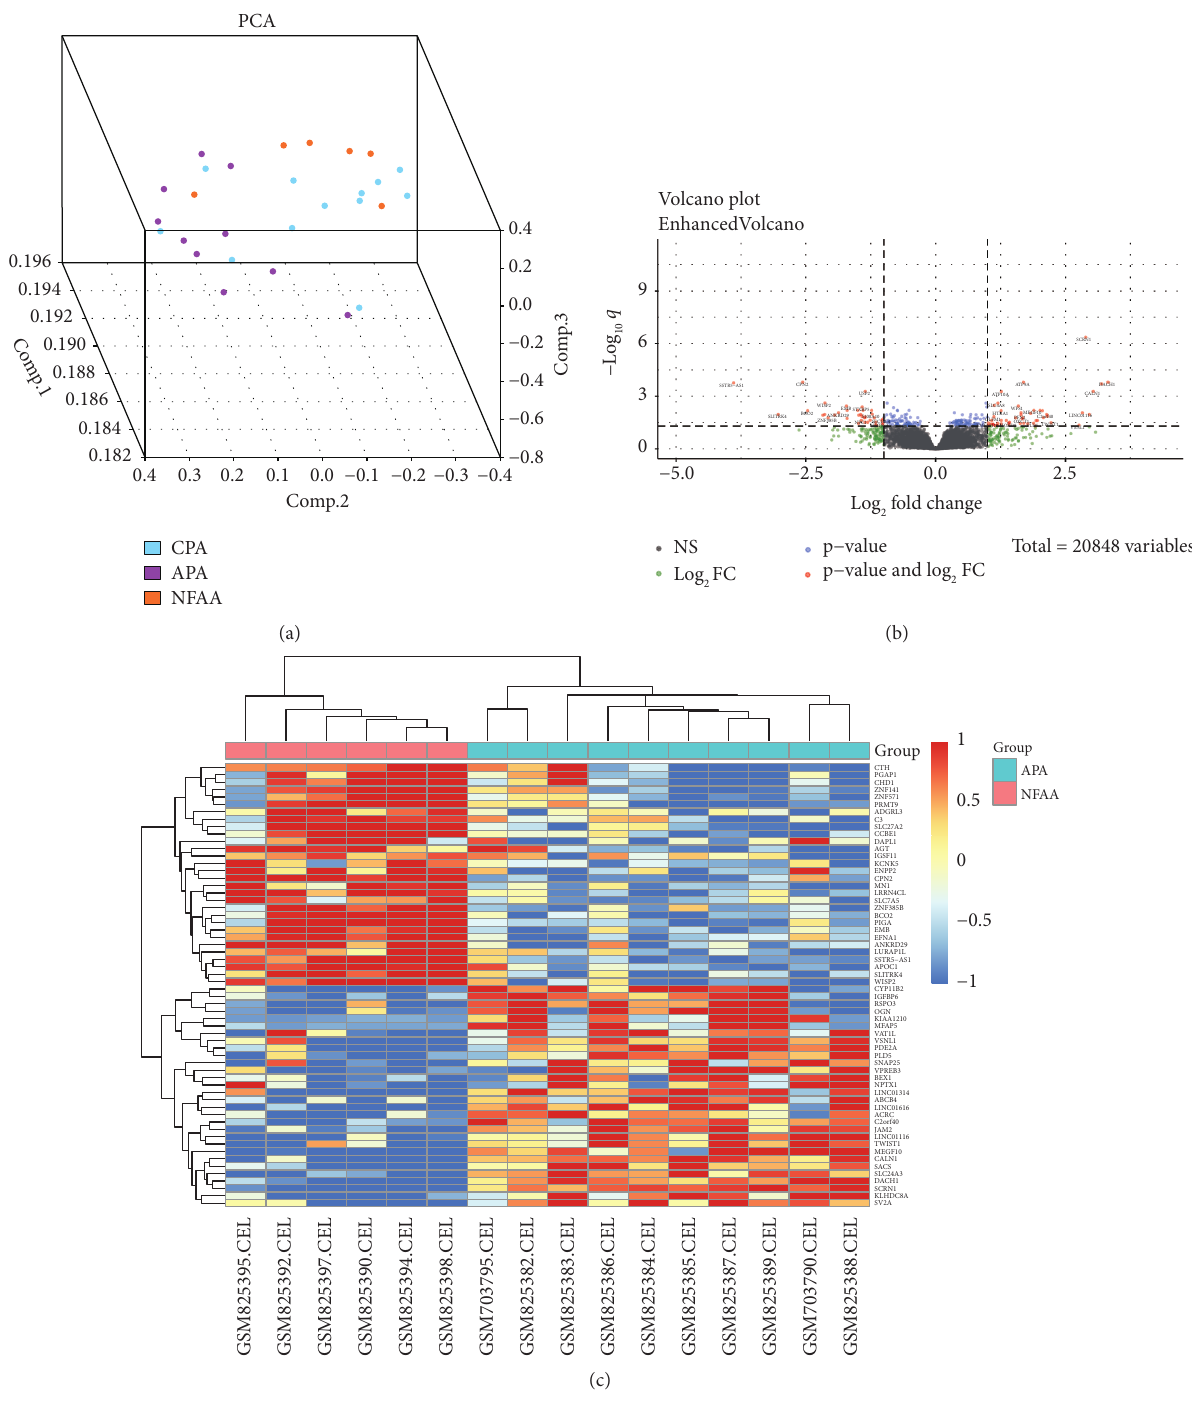
Figure 3: Screening of differentially expressed genes (DEGs) in combined datasets. (a) Spatial graph for PCA of the combined dataset. The light blue spots represent CPA, the purple spots represent APA, and the yellow spots represent NFAA. (b) Volcano map of differently expressed genes between APA tissues and NFAA tissues. (c) Heat map of the top 100 DEGs between the APA and